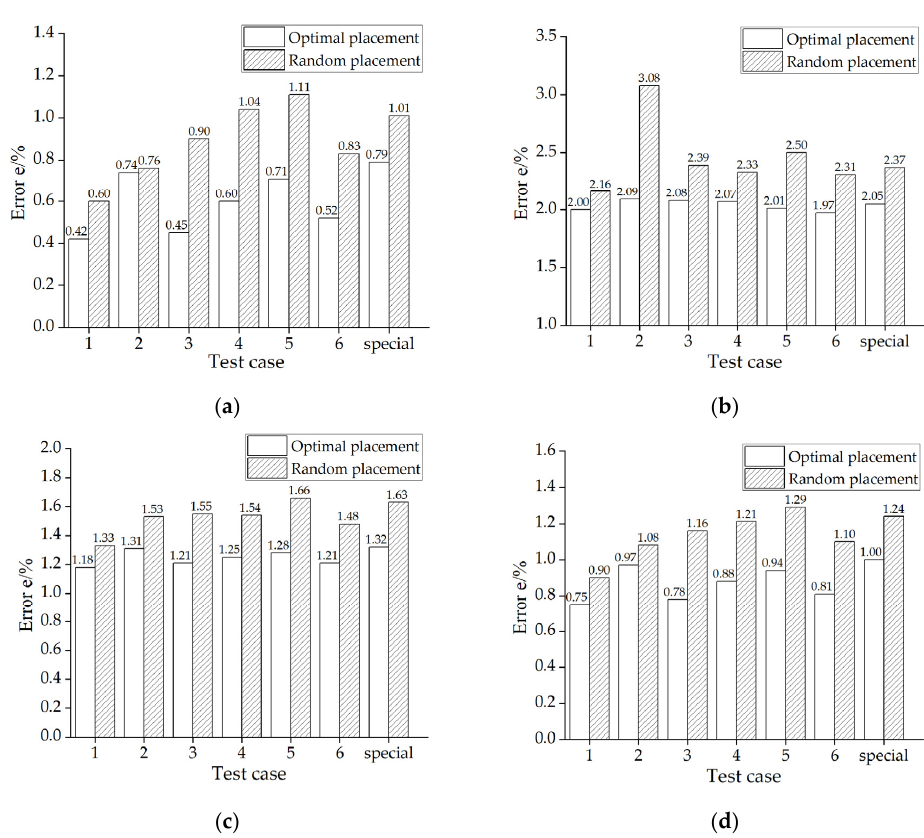
Figure 5. Comparison of reconstruction errors between the optimal placement and random placements in different test cases with different levels of noise. ( a ) Original measurement data; ( b ) SNR = 40 dB; ( c ) SNR = 45 dB; ( d ) SNR = 50 dB.